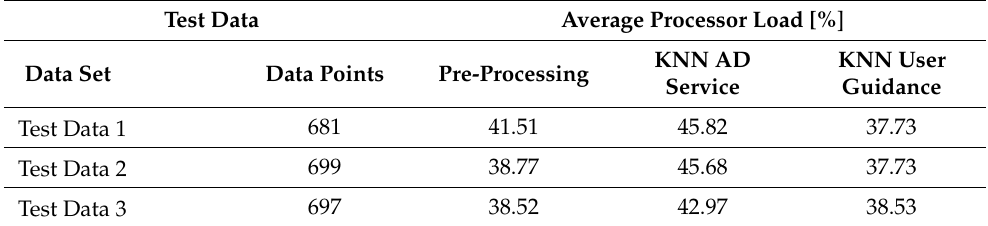
Figure 19. Quantitative assessment of the system implementation’s runtime for three datasets. Table 1. Measurement of the duration of feature extraction and inference for three test